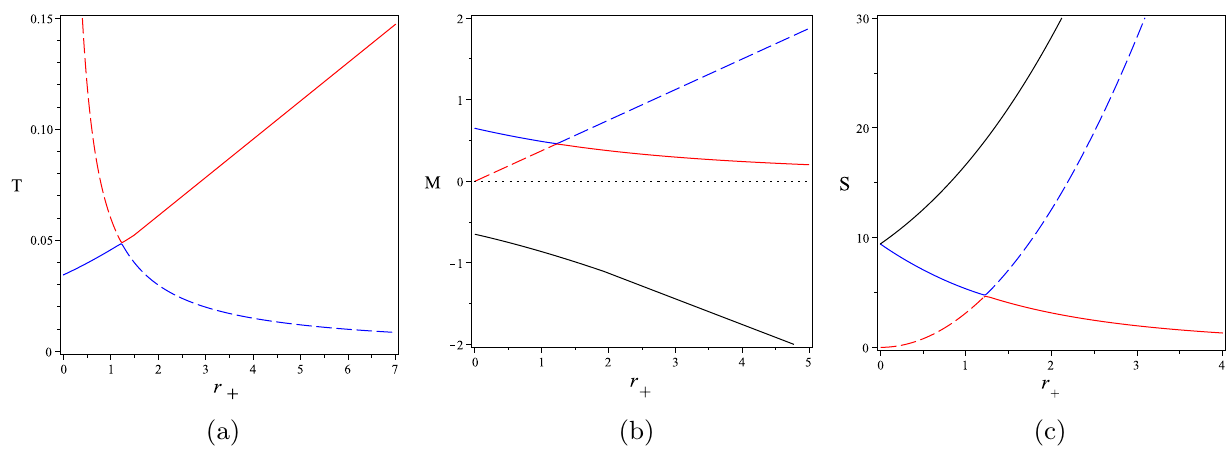
Fig. 1 Plots of T , M and S in terms of r + for α = 0 . 5 , c 1 = − 0 . 1406. In all panels the dashed line curves indicate Schwarzschild-like behavior and solid line curves non-Schwarzschild-like behavior Fig. 2 The behavior of heat capacity (left) and free energy (right) in terms of r + for α = 0 . 5 , c = − 0 . 1406 1